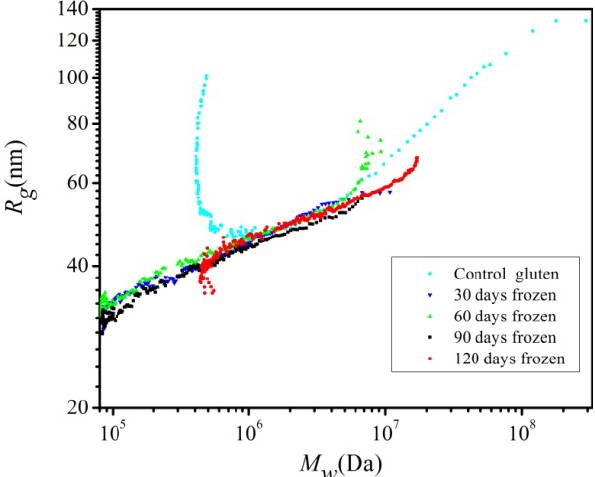
Figure 5. Comparison of the conformation plot, R frozen storage gluten polymeric proteins using 500 mM acetic acid